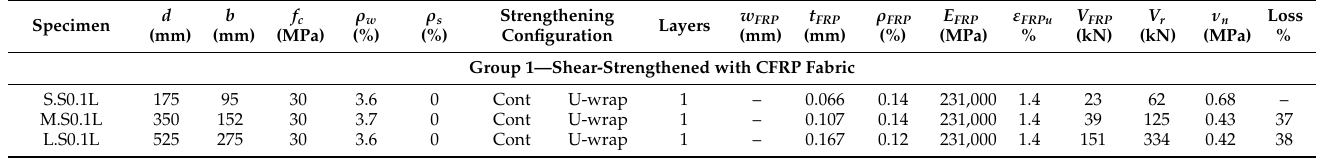
Figure 3. Details of tested beams: ( a ) cross sections of geometrically similar T-beams (mm) and ( b ) typical elevation. Table 3. Experimental program and test